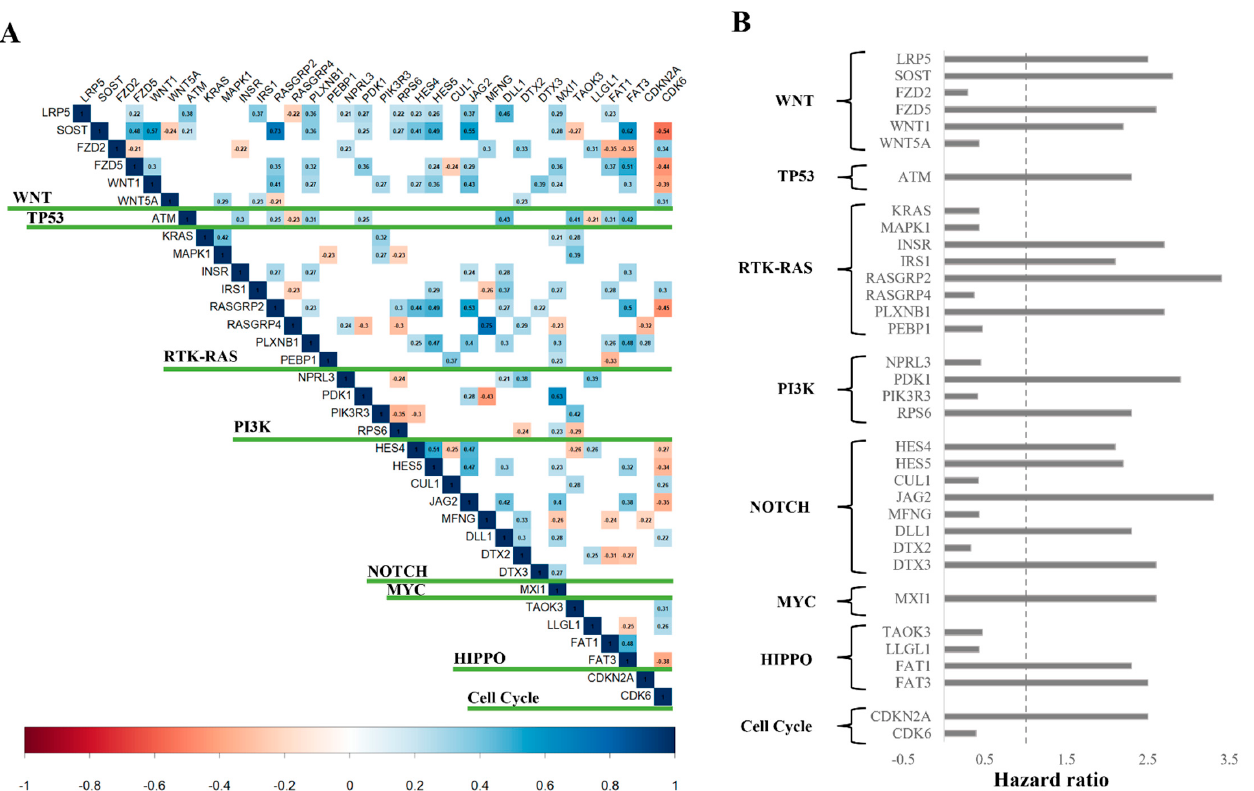
Figure 3. ( A ) Correlation plot showing significantly correlated canonical pathway genes ( p < 0.05). Negative correlated genes are shown in red, and positive in blue. ( B ) List of 34 genes found significantly associated with survival ( p < 0.05), their associated canonical pathways, and corresponding HR values.